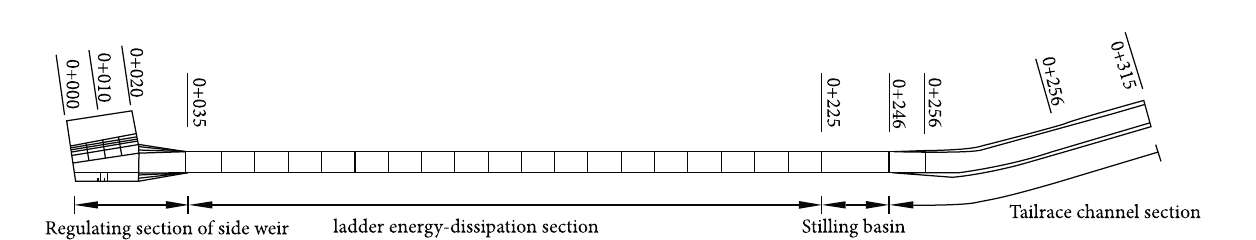
Figure 2: The planar layout of model.